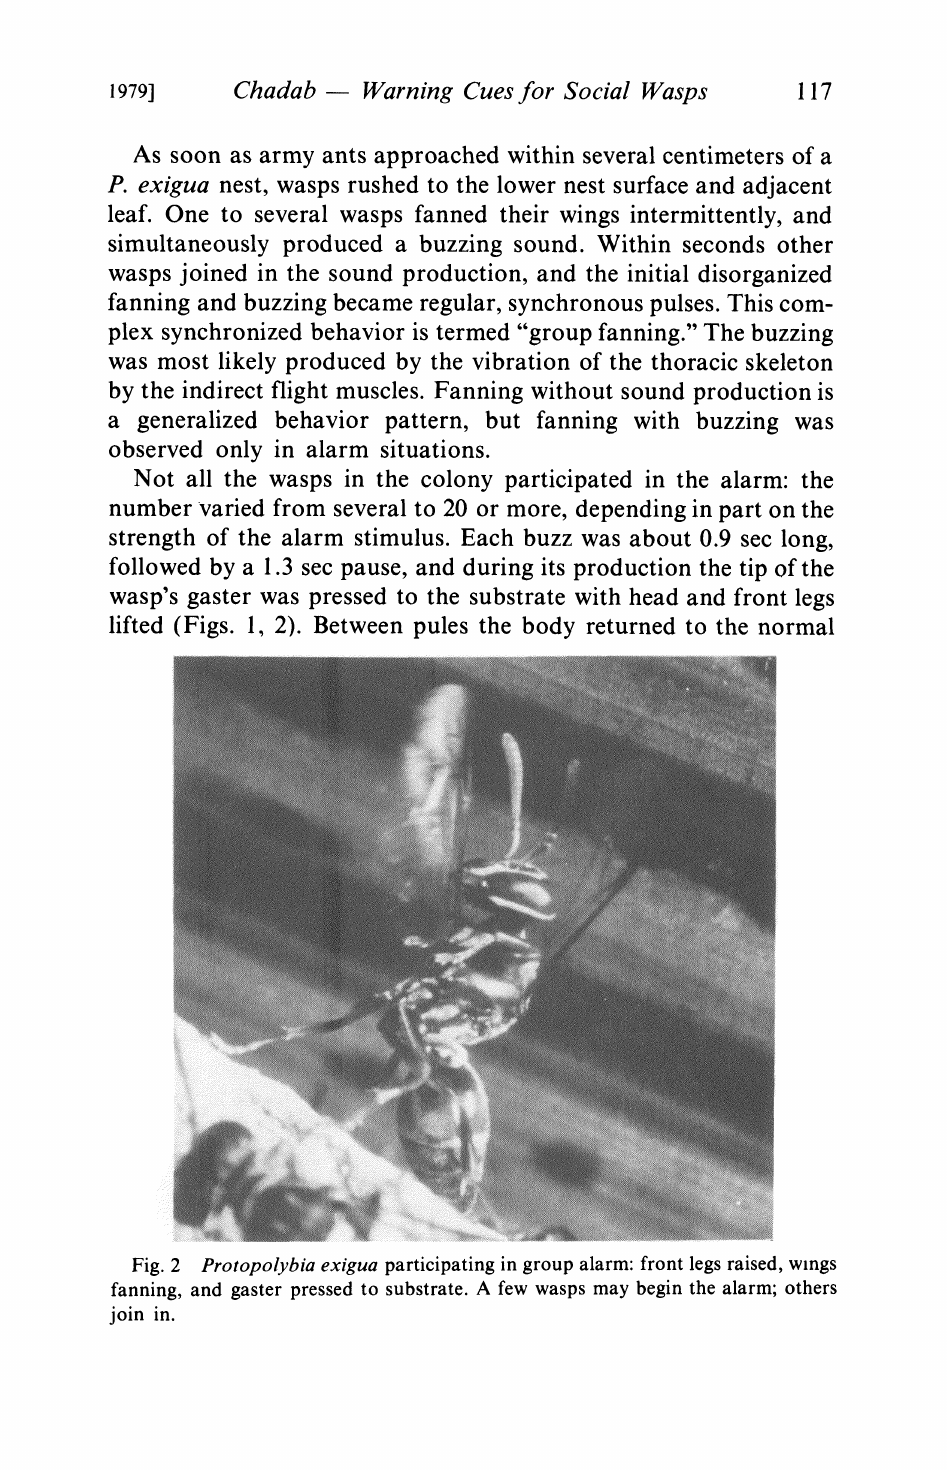
Fig. 2 Protopolybia exigua participating in group alarm: front legs raised, wngs fanning, and gaster pressed to substrate. A few wasps may begin the alarm; others join